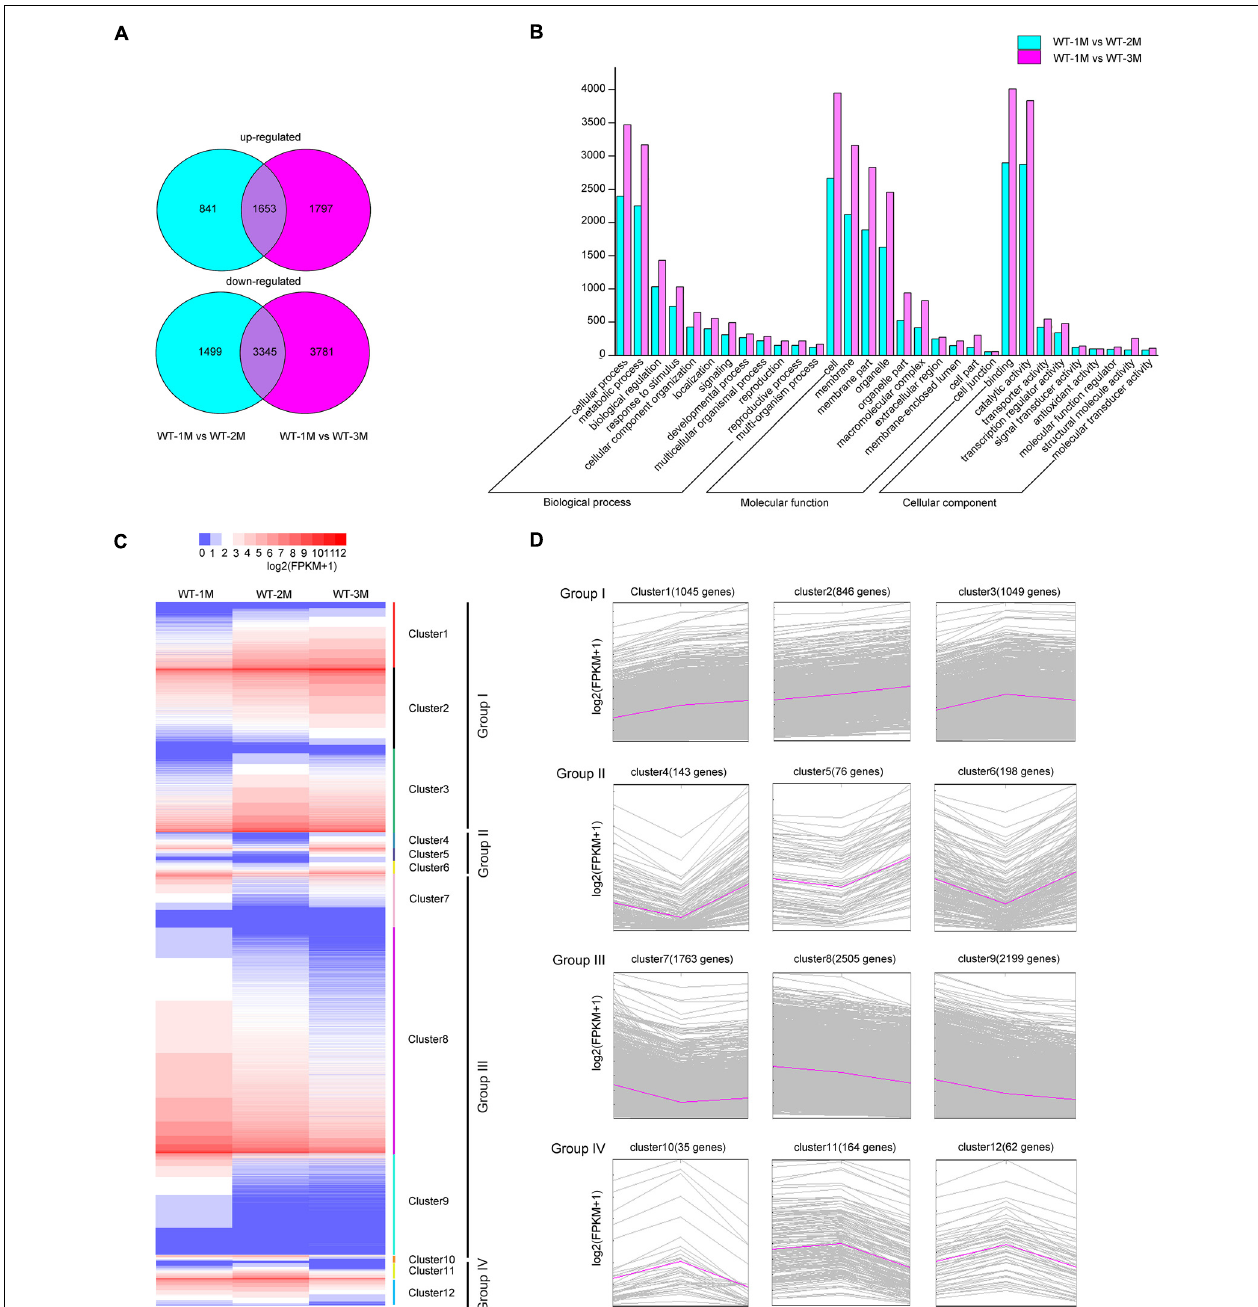
FIGURE 2 | Analysis of differentially expressed genes in WT-2M and WT-3M plants compared with WT-1M plants. (A) Numbers of upregulated and downregulated DEGs in WT-1M vs. WT-2M and WT-1M vs. WT-3M. P < 0.01, fold change ≥ 1 or ≤ –1. (B) Numbers of DEGs of “Biological process,” “Cellular component,” and “Molecular function” in different functional categories in WT-1M vs. WT-2M and WT-1M vs. WT-3M. (C) Hierarchical cluster analysis of DEGs of WT plants at three different months. The color scale bar on the top indicates the expression level. The values given in the legend are log2(FPKM + 1). (D) 12 clusters (clusters 1–12) were obtained by the soft clustering method for DEGs. The horizontal axis represents the three months (months 1, 2, and 3). The vertical axis represents fold changes in gene expression.